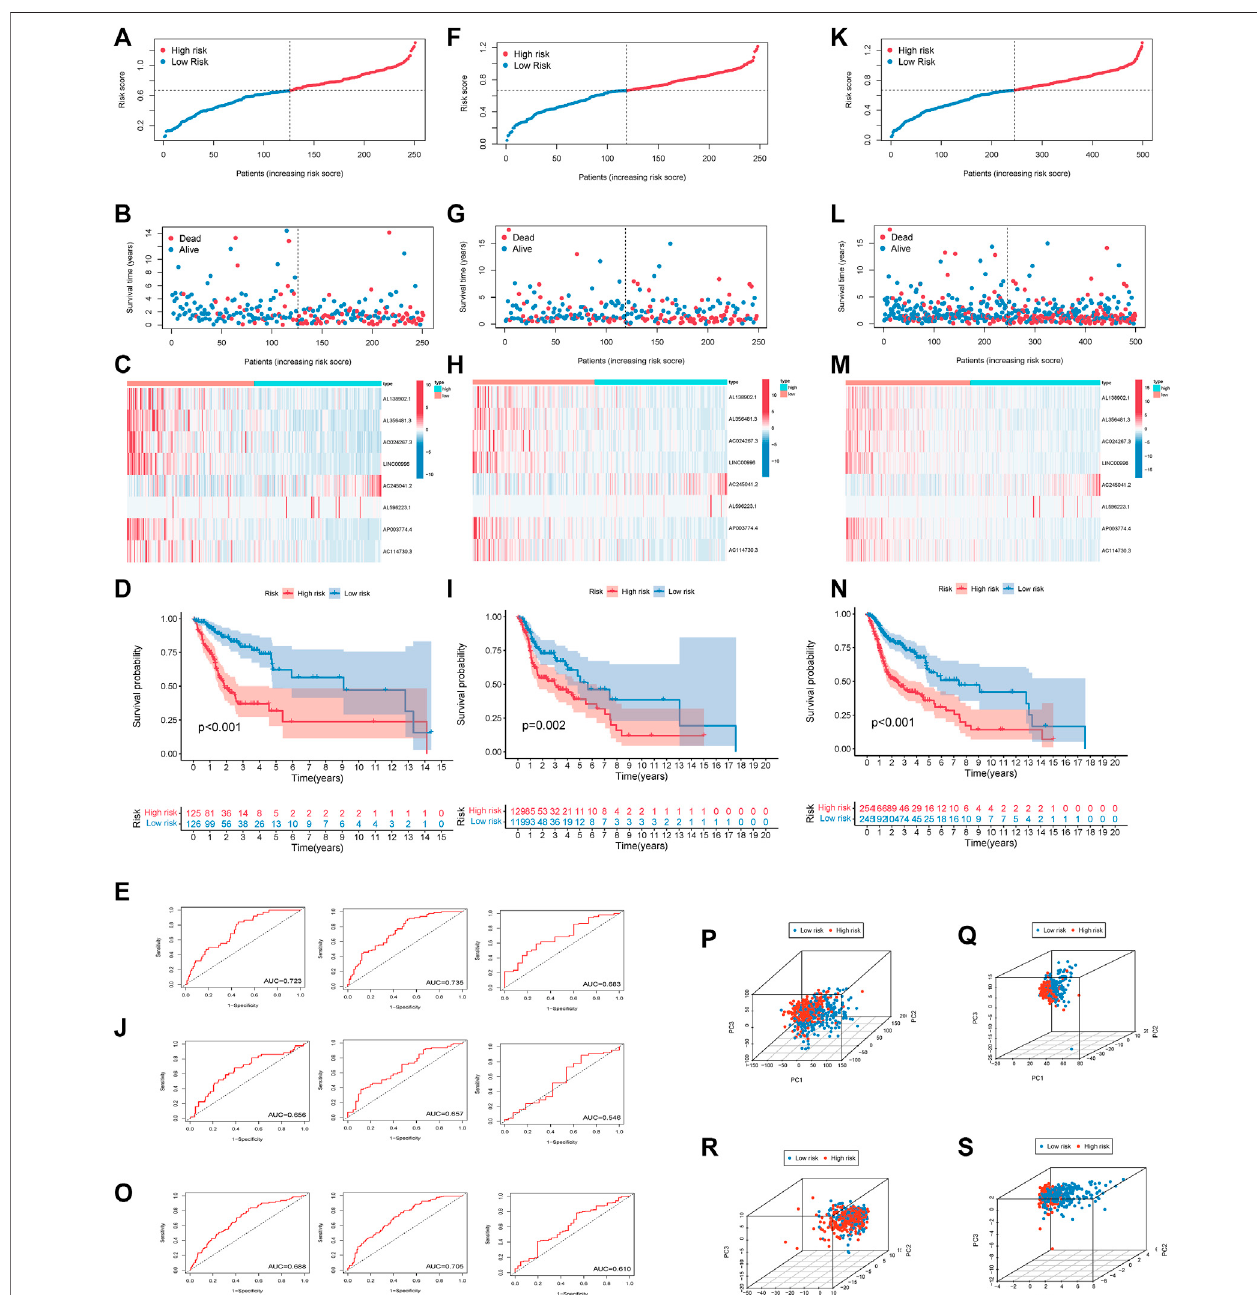
FIGURE 3 | Estimation of the prognosis model of 8 EMT-related lncRNAs. (A) . The survival rate was signi fi cantly associated with the risk score in the training set. (B) . Scatterplot of patient survival in the training set. (C) . Heatmap of 8 EMT-related lncRNAs in the training set. (D) . Kaplan – Meier survival curves of the high-risk group and the low-risk group in the training set. (E) . ROC curve based on the risk score model in the training set. (F) . The survival rate was signi fi cantly associated with the risk score in the test set. (G) . Scatterplot of patient survival in the test set. (H) . Heatmap of 8 EMT-related lncRNAs in test set (I) . Kaplan – Meier survival curves of the high-riskgroupand thelow-riskgroup inthetestset. (J) .ROCcurve based ontheriskscoremodelinthetest set. (K) .Thesurvivalratewassigni fi cantlyassociatedwith theriskscoreinallsets. (L) .Scatterplotofpatientsurvivalinallsets. (M) .Heatmapof8EMT-relatedlncRNAsinallsets. (N) .Kaplan – Meiersurvivalcurvesofthehigh-risk group and the low-risk group in all sets. (O) . ROC curve based on the risk score model in all sets. Principal Component Analysis Veri fi es the Performance of The Risk Model (allgenes, EMT-related genes, EMT-related LncRNAs, 8EMT-related LncRNAs). Red and blue dots representhigh-risk and low-risk patients, respectively (P – S) .